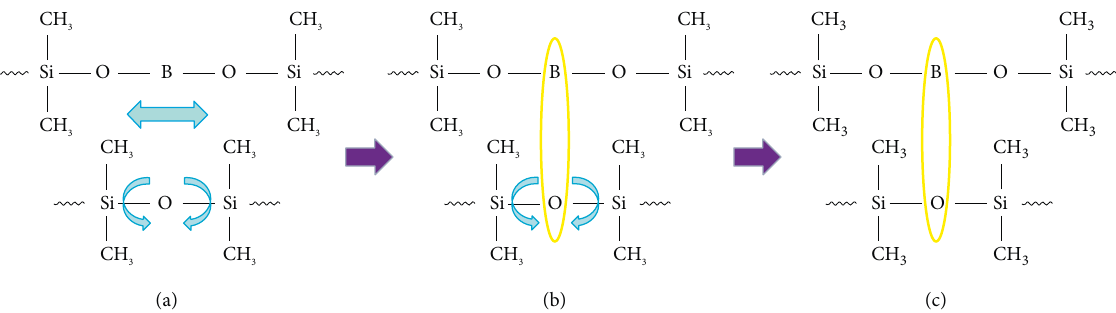
Figure 8: The movement mode of the internal molecular chains (a) when MRSP behaves as a liquid, (b) when MRSP behaves as a colloid, and (c) when MRSP behaves as a solid.